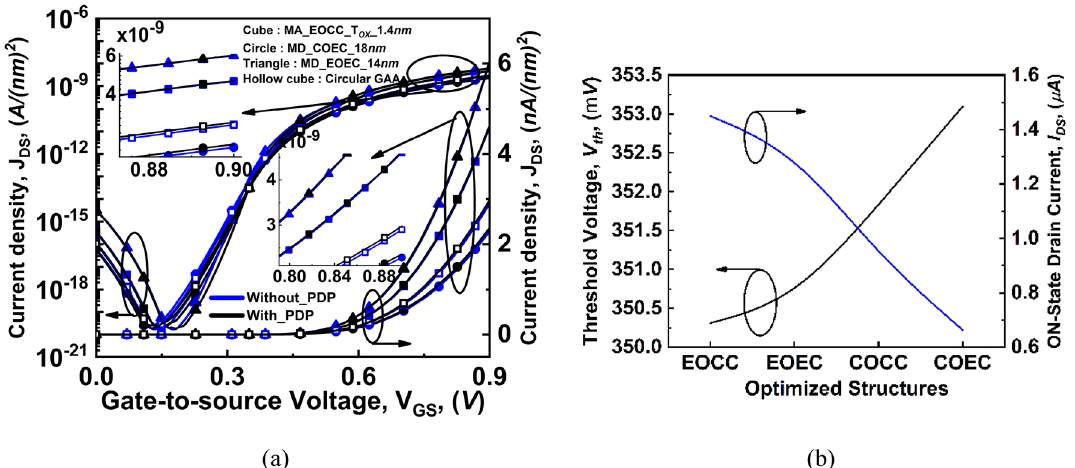
Figure 7. ( a ) Comparison of variation of drain current density (J DS ) as a function of gate-to-source voltage at V DS = 0.3 V for all possible optimized structures when PDP is invoked, and ( b ) variation in threshold voltage and ON-state drain current as a function of deformation in device